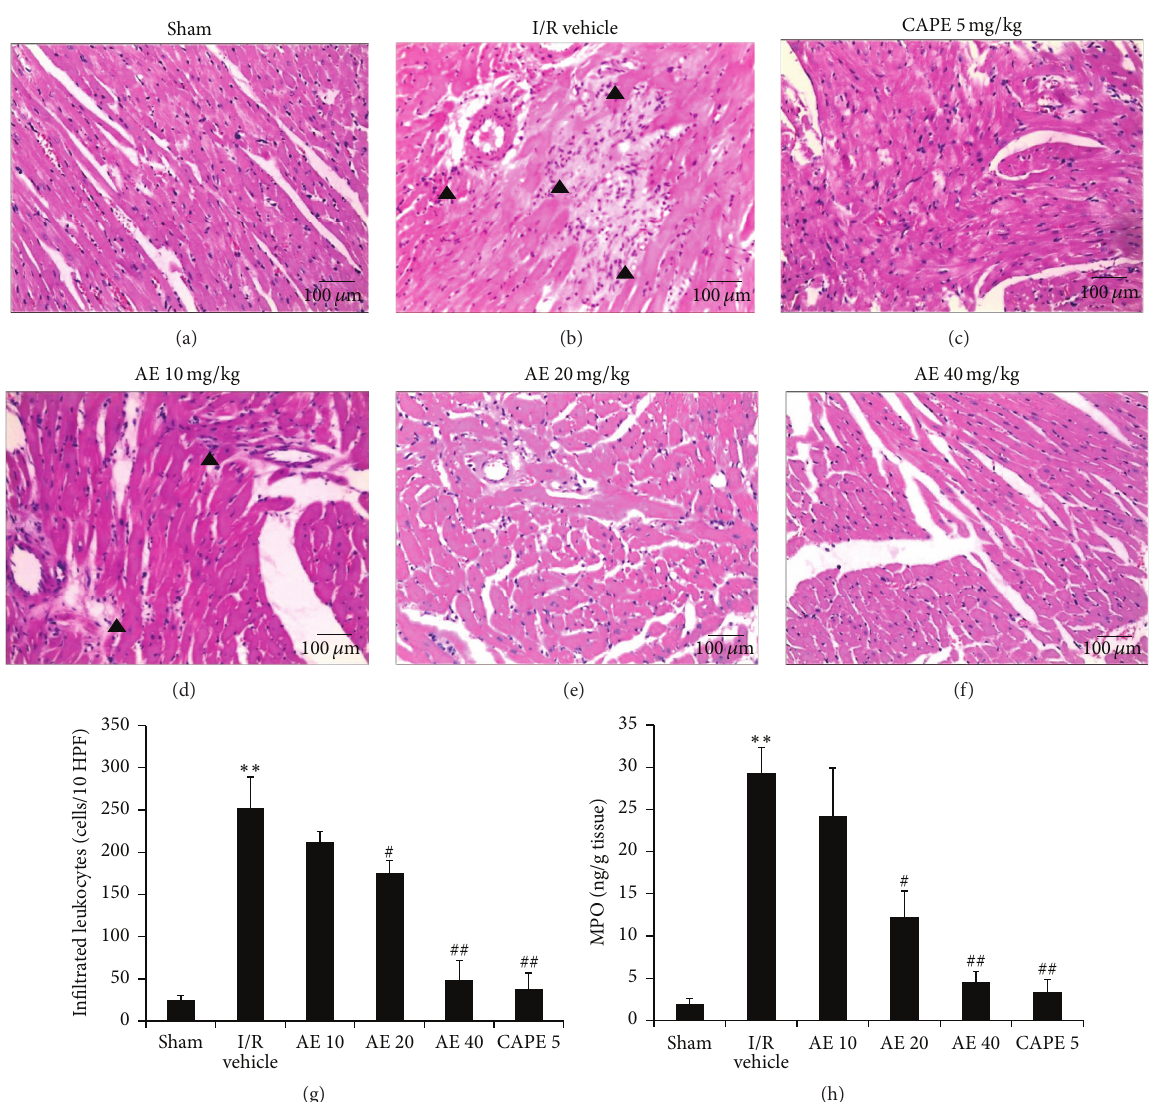
Figure 7: Effects of AE on histopathological changes after I/R in hearts. (a–f) Left ventricular sections stained with hematoxylin and eosin from representative rats are shown ( × 20, arrowheads, leukocytes infiltration). (a) Sham. (b–f) Hearts were subjected to 30min ischemia followed by 24-hour reperfusion. Saline ((b), 1mL/kg), CAPE 5 mg/kg 40 mg/kg (c), or different doses of AE (10, 20, or 40mg/kg) were administered via the tail vein 1min before reperfusion. (g) Number of infiltrated leukocytes, 10 fields per heart specimen. (h) MPO activities. ∗∗ 𝑃 < 0.01 , versus Sham; # 𝑃 < 0.05 versus I/R vehicle; ## 𝑃 < 0.01 . 𝑛 = 5 in each group. Leucocyte infiltration 󳵳